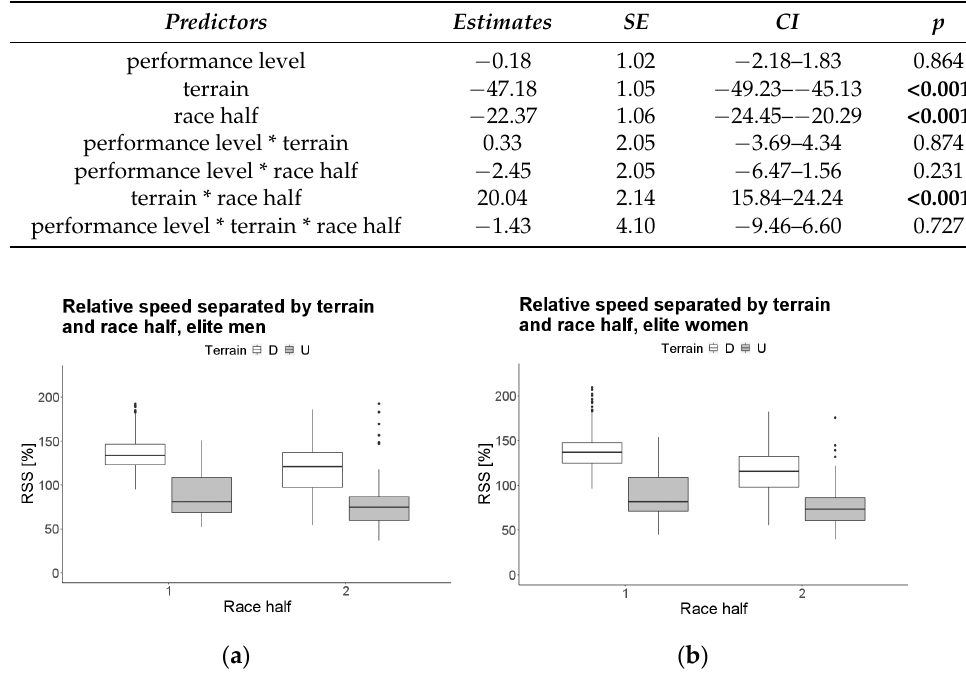
Figure 3. Boxplots representing the two-way interactions between terrain and race half for the elite dataset models, male ( a ) and female ( b ).